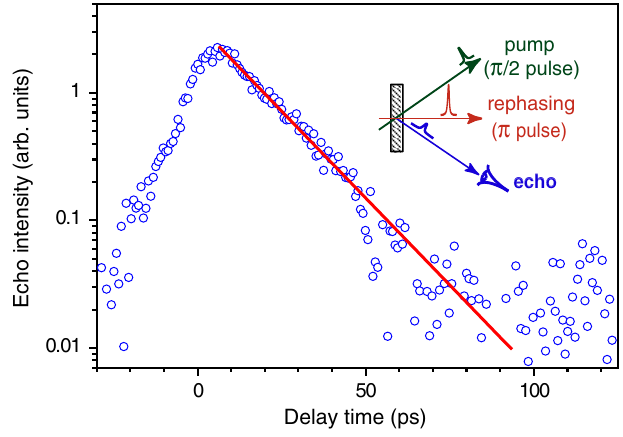
FIG. 6. Photon echo for Si:B transition line 1. The abscissa is the time between the (cid:2)= 2 and (cid:2) pulses. The inset shows a schematic of the beam